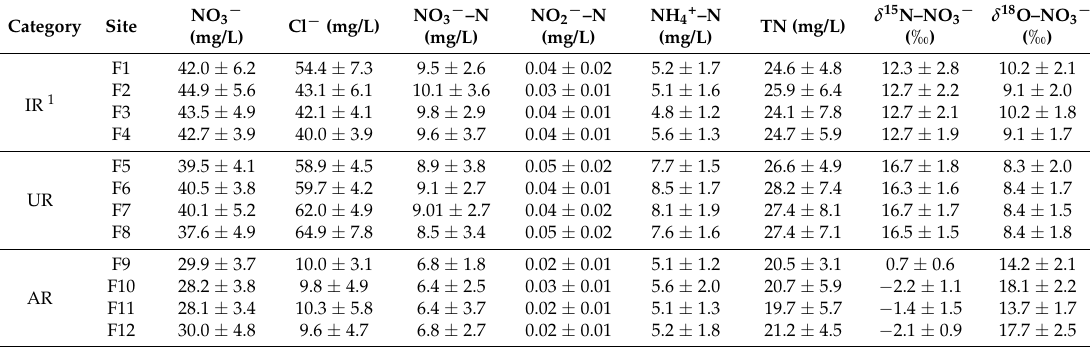
Table 1. Mean concentration of hydrochemical parameters and the environmental isotopic ratios in water samples in the lower reach of Fenhe